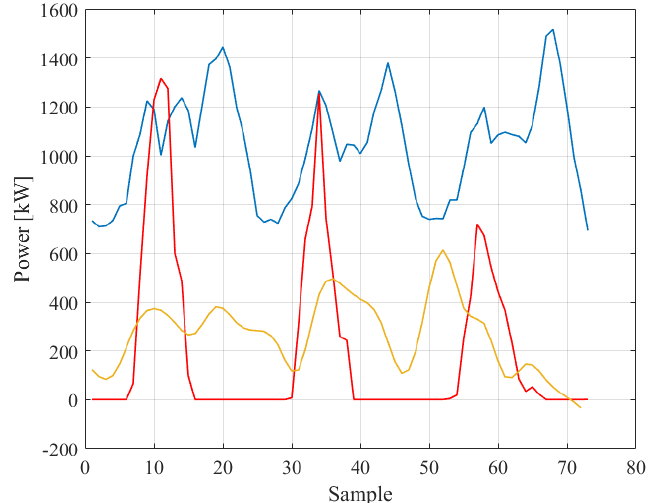
Figure 31. Predicted load (blue), PV (red), and wind power (yellow) in the middle of May 2016.